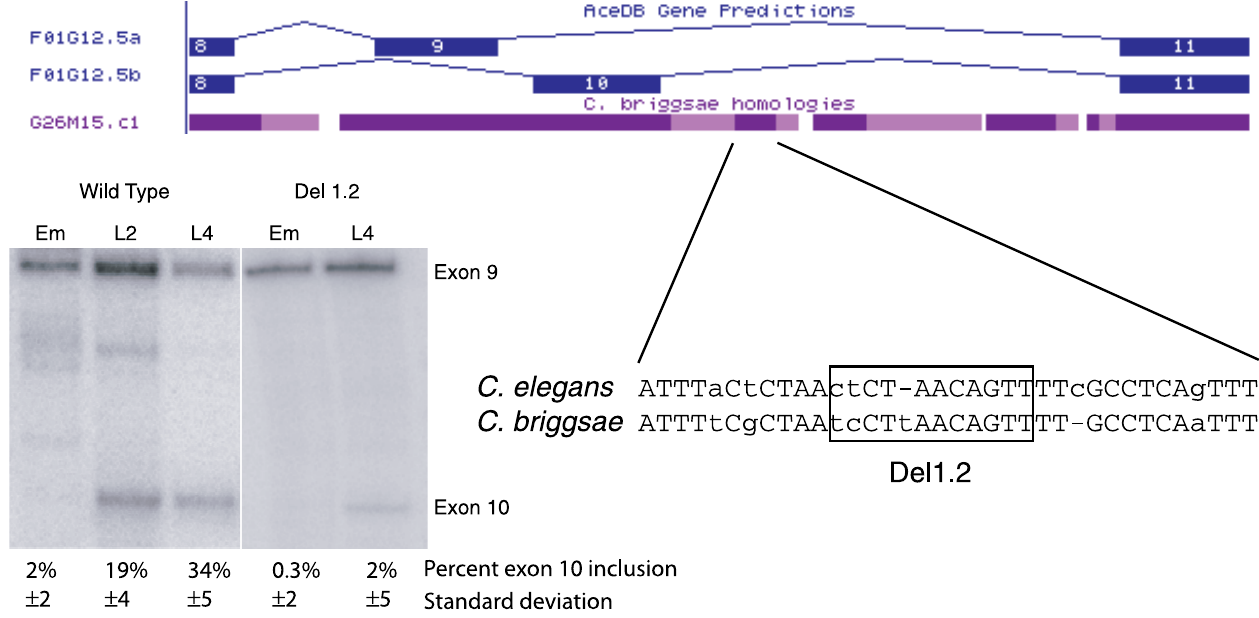
Figure 2. An Intronic Element Regulates let-2 Alternative Splicing The top of this figure shows the alignment of C. elegans and C. briggsae sequences for the alternatively spliced region of let-2 . Blue tracks indicate the splicing for the embryonic (top) and adult (bottom) isoforms. The purple track indicates homology between the C. briggsae and C. elegans genomes as determined by WABA. Dark purple tracks indicate regions of strong homology ( . 70%). The sequence of the first conserved element of intron 10 is shown. The box indicates the part deleted and replaced with the sequence GAA in the del1.2 splicing reporter construct. The lower left part of the figure shows the results of 32 P RT-PCR reactions with primers specific for the splicing reporter. Products for exon 9- or exon 10-containing messages are indicated. In embryos, only usage of exon 9 is detected for either reporter. At the L4 stage, 34% of the wild-type reporter messages contain exon 10 while del1.2 mutant messages contain only a trace amount of this exon. DOI: